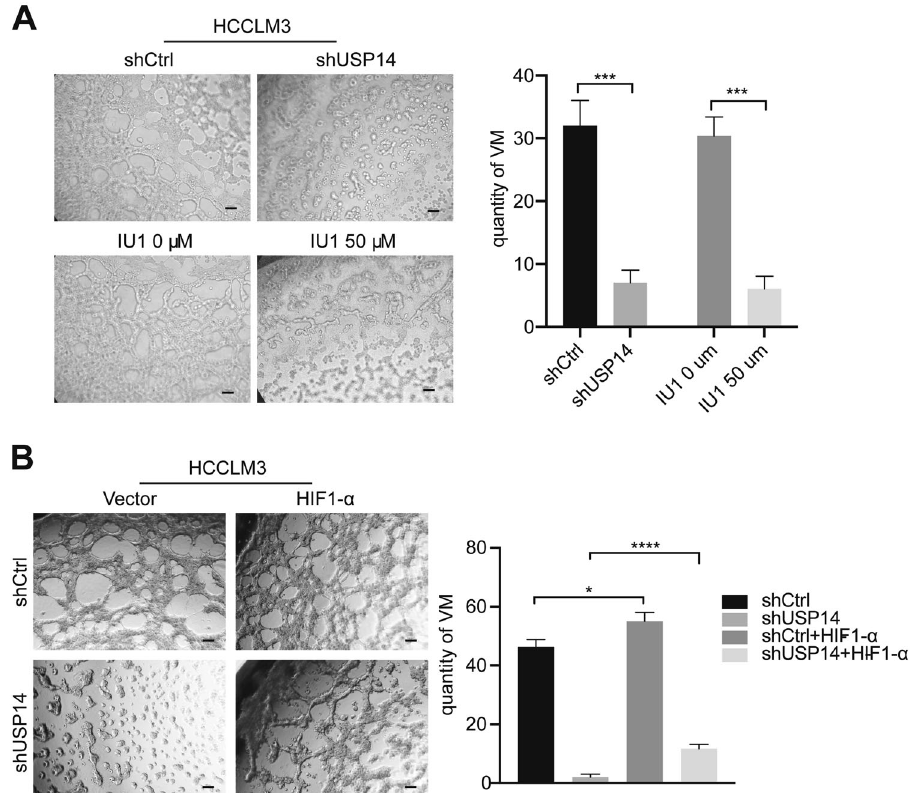
* P < 0.05; ** P < 0.01; *** P < 0.001; **** P < 0.0001; ns = no signi fi